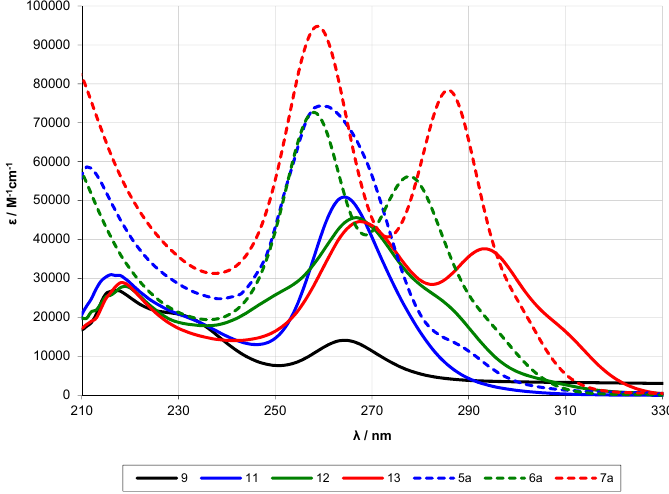
Figure 7. Comparison of the UV spectra of different dodeca-, trideca-, and tetradecasilanes with either triisopropylsilyl or trimethylsilyl groups in terminal and internal positions.